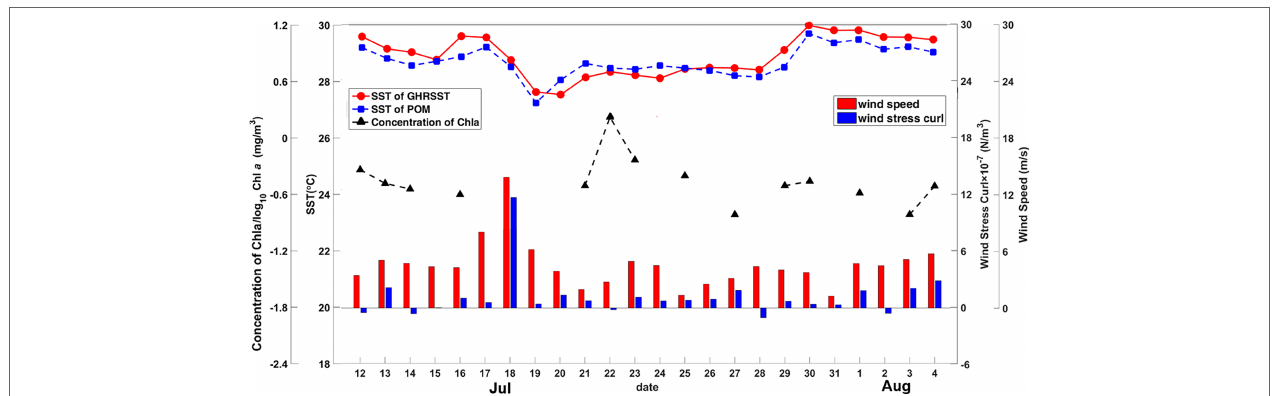
FIGURE 5 | Time series of SST (data from GHRSST), Chl-a, wind speed, and wind stress curl from July 12 to August 4, All the data are averaged in the typical zone of the